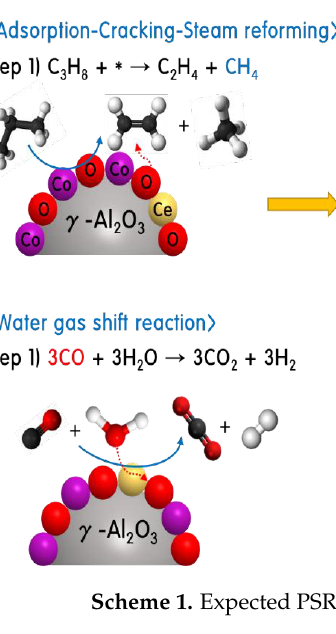
Figure 10. XPS of the two representative catalysts, 30Co/70 γ -Al 2 O 3 ( A ) and 30Co .85 Ce 0.15 /70 γ -Al 2 O 3 ( B ), before and after PSR.